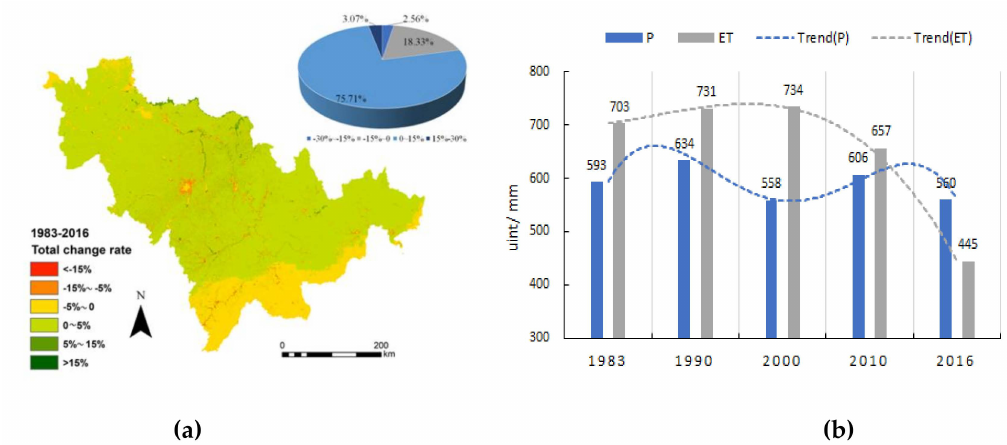
Figure 9. ( a ) Total spatial change and change rate of water conservation from 1983 to 2016; ( b ) the total amount of P, actual ET, and change trends of Jilin province in 1983, 1990, 2000, 2010, and